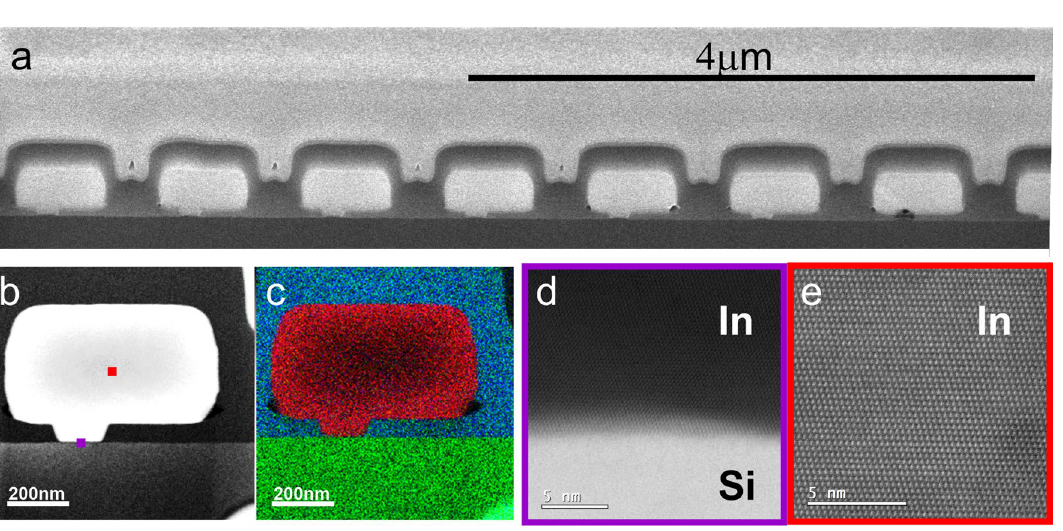
Fig. 3 Cross-sectional images of annealed and recrystallized In structures in templates. a Low resolution cross section of seven devices. b TEM image of a single structure including the seed region. c Corresponding EDX map with indium (red), silicon (green) and oxygen (blue). d , e High-resolution dark field TEM image of In-Si heterointerface and bulk part with collection regions marked with a coloured square in ( b